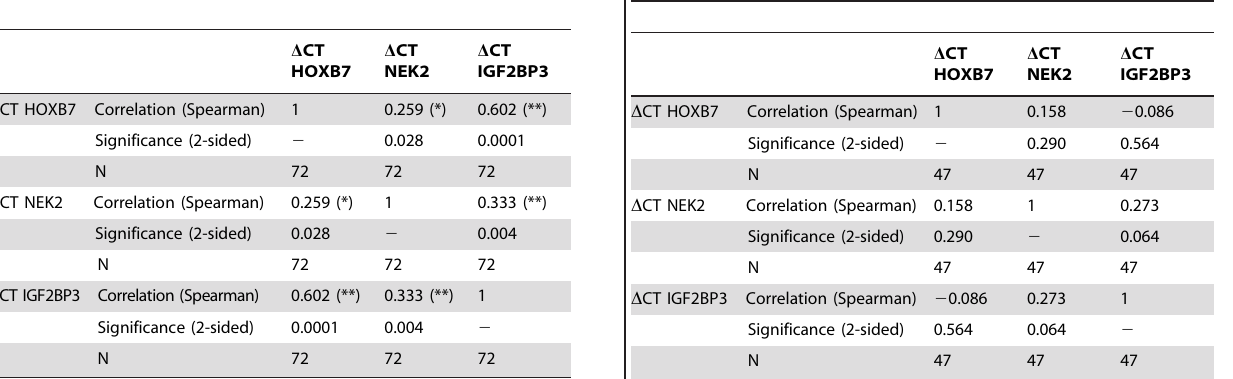
Table 3. Correlation between candidate gene D CT levels in patients with benign